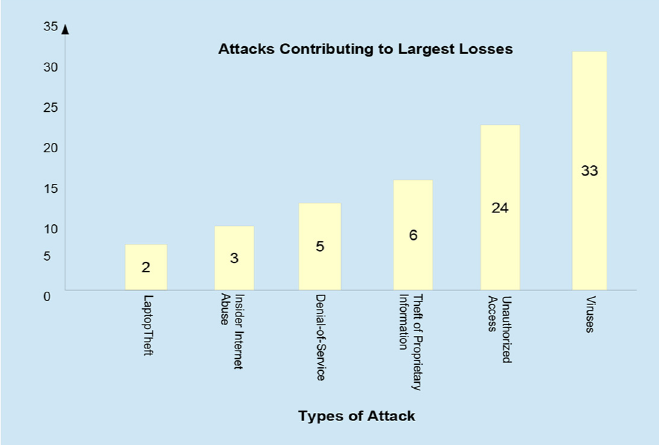
Figure 3. Bar chart of attacks with the largest lost